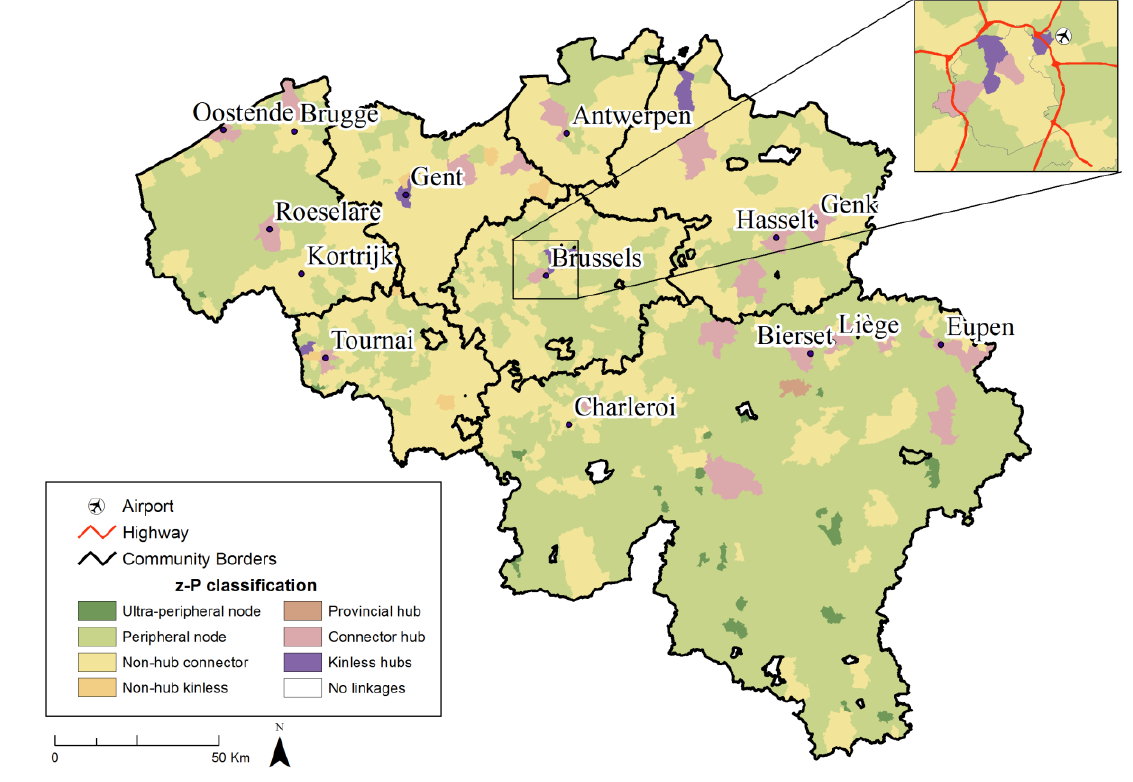
Figure 5: z-P parameter space of logistics communities (Fig